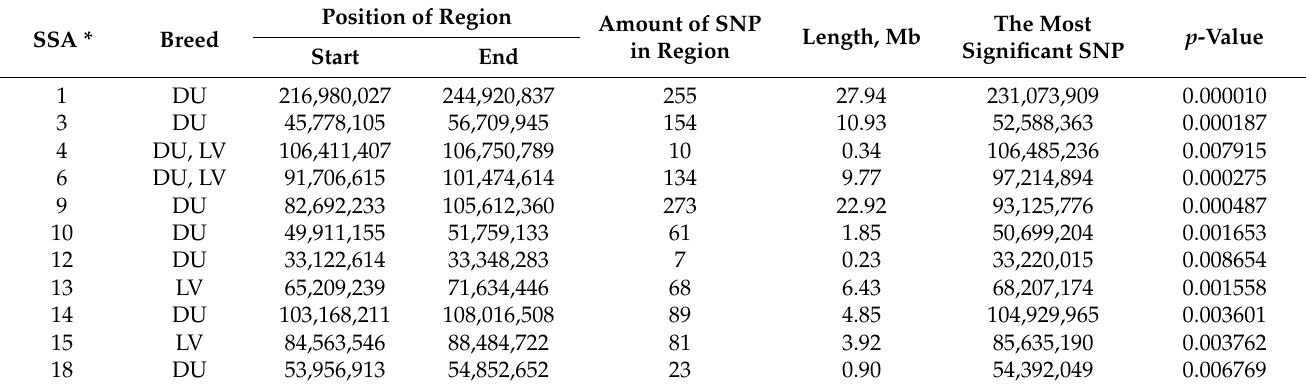
Figure 2. Signatures of selection in the genomes of the studied breeds based on the hapFLK statistics. Values for the X -axis are pig autosomes, and those for the Y -axis are values of statistical significance ( − log 10 p -values). The blue line indicates the threshold of significance at p < 0.01 (i.e., − log 10 ( p ) > 2). Each chromosome is marked with different color. Magnified plots for 11 putative regions identified by hapFLK analysis in LV and/or DU breeds are presented in Supplementary Materials, Figure S2. Table 1. HapFLK regions identified in the genome of the studied LV and DU pig